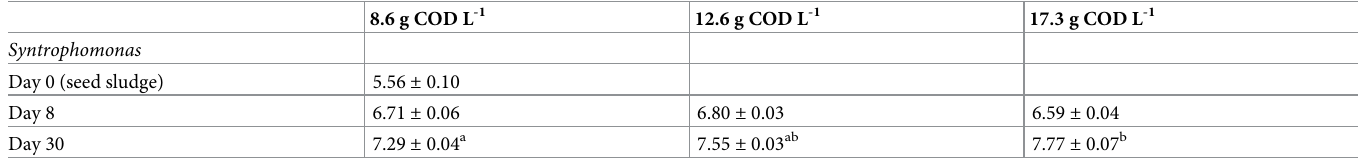
Table 3. The transition of 16S rRNA copies for Syntrophomonas (log copies mL -1